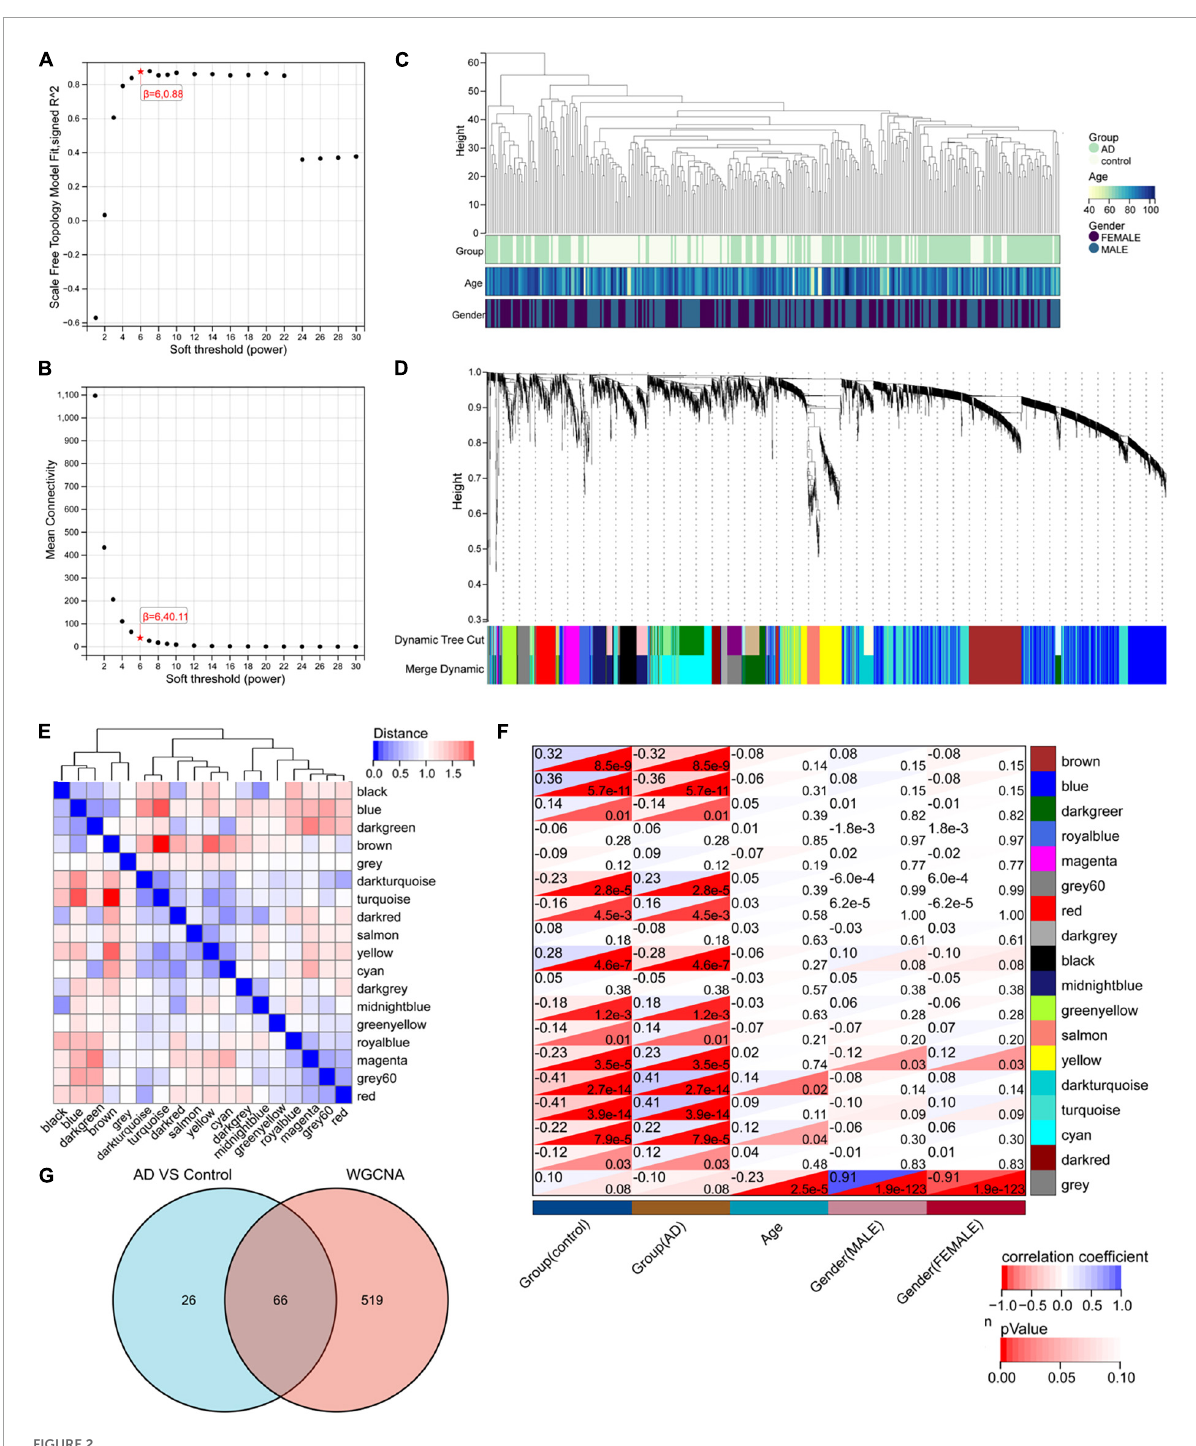
FIGURE2 WGCNA analysis results. (A) The corresponding scale-free topological model fit indices at different soft threshold powers. (B) The corresponding mean connectivity values at other soft threshold powers. (C) Sample clustering. (D) Cluster dendrogram of genes. (E) Correlation map of vector clustering of 18 modules. (F) Correlation heatmap between modules and clinical features, the lower left corner of each grid is the P -value, and the upper right corner is the correlation coefficient. (G) The Wayne diagram of intersection with 585 hub genes obtained by WGCNA and 92 DEGs by